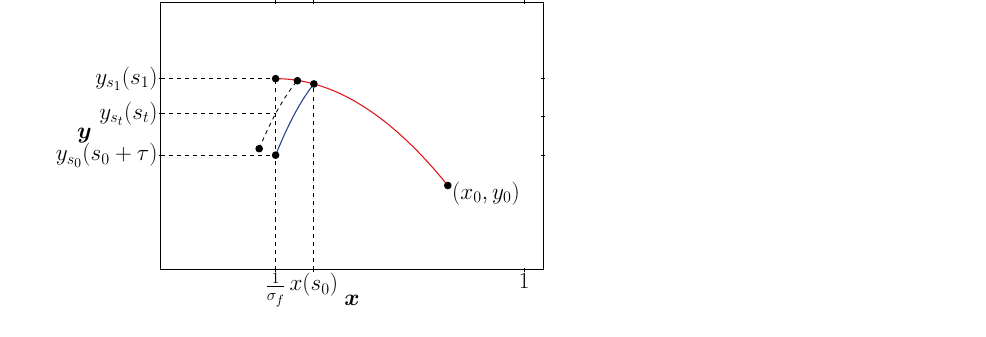
Figure 11. Trajectories ( x t , τ , y t , τ ) for t ∈ [ s 0 , s 1 ] when σ m = σ f